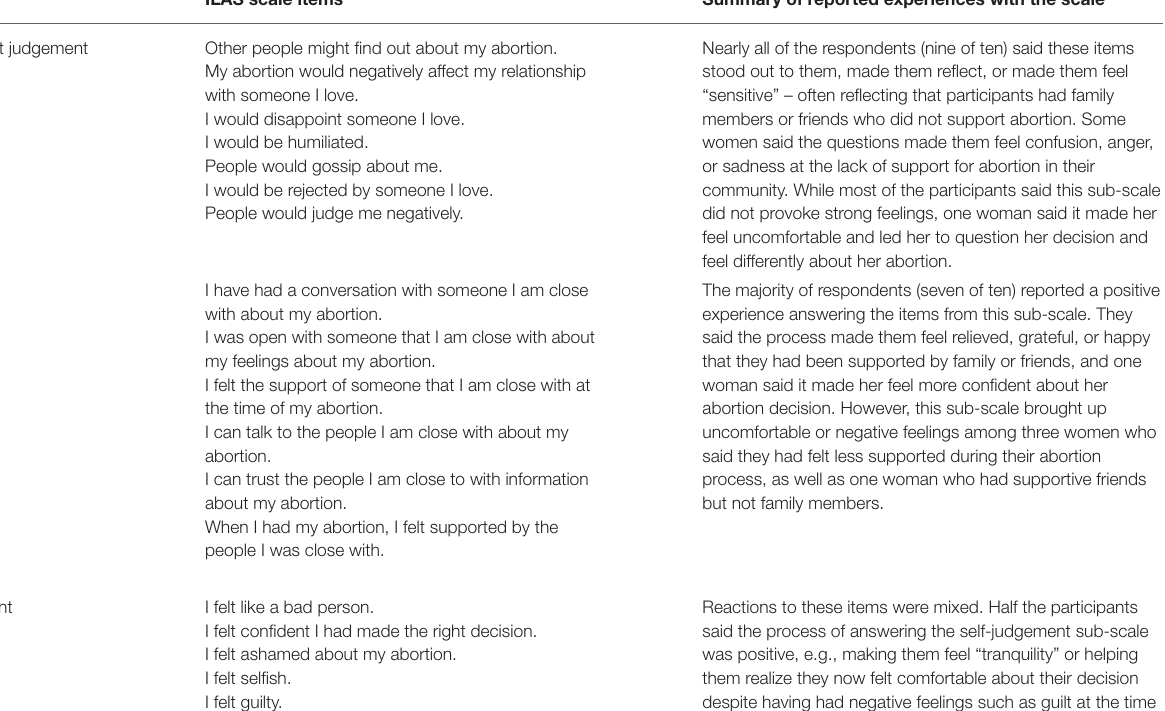
TABLE 1 | Women’s reported experiences, by ILAS sub-scale. Sub-scale ILAS scale items Summary of reported experiences with the scale Worries about